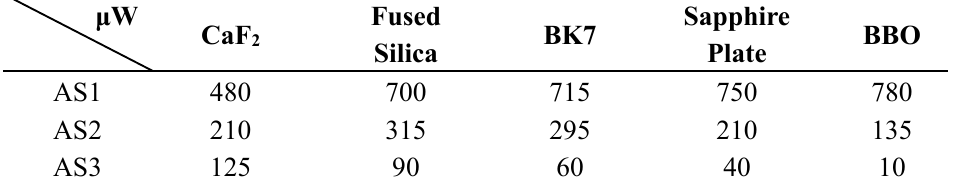
Table 1. The output power of AS1-AS3 with five commonly used third-order nonlinear media. The external cross-angle of two pump beams is 1.8°, while the input powers of Beam 1 and Beam 2 are 7 mW and 25 mW, respectively [60].